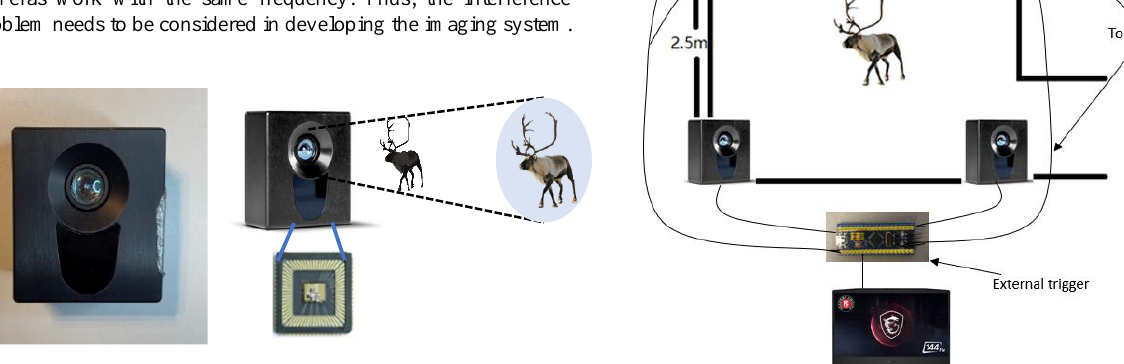
Figure 2. The Pico Monstar camera and its working principle.